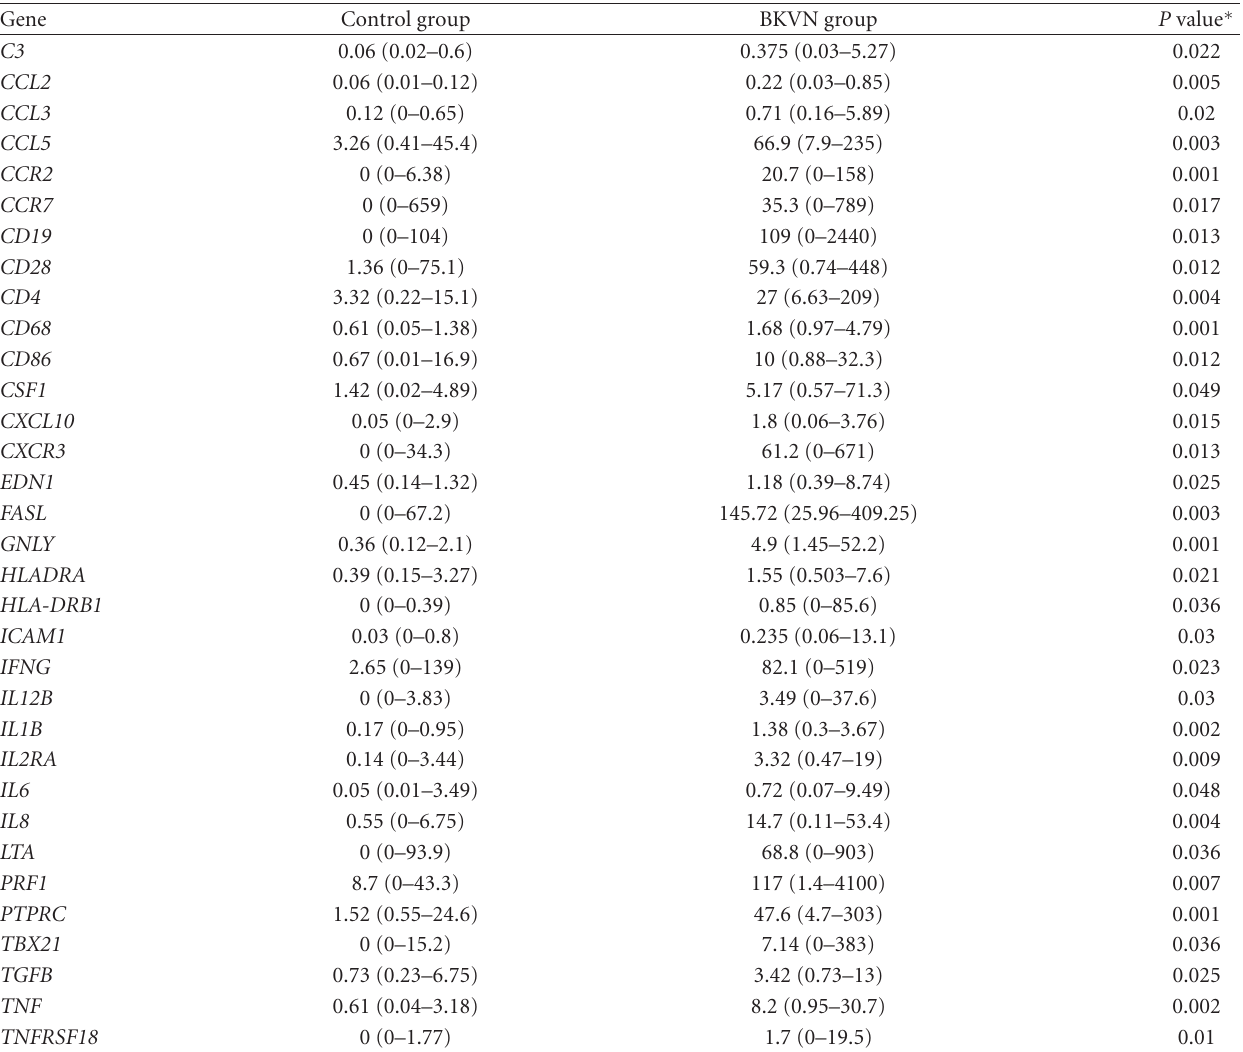
Table 4: Genes with di ff erent regulation in polyoma BK